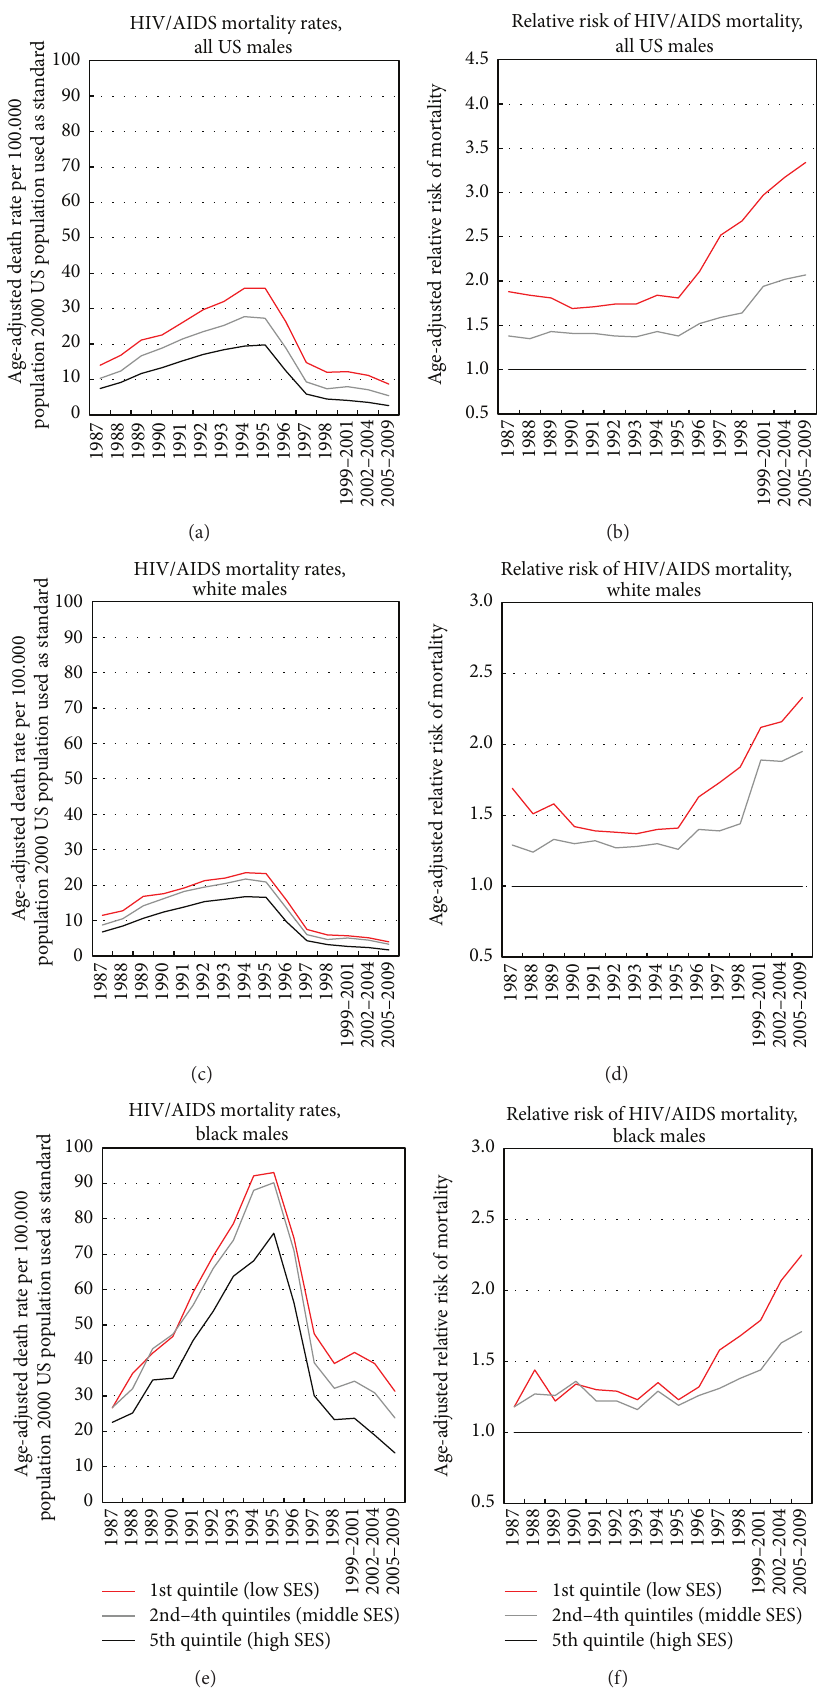
Figure 4: Trends in race-specific HIV/AIDS mortality by area socioeconomic deprivation, US males,